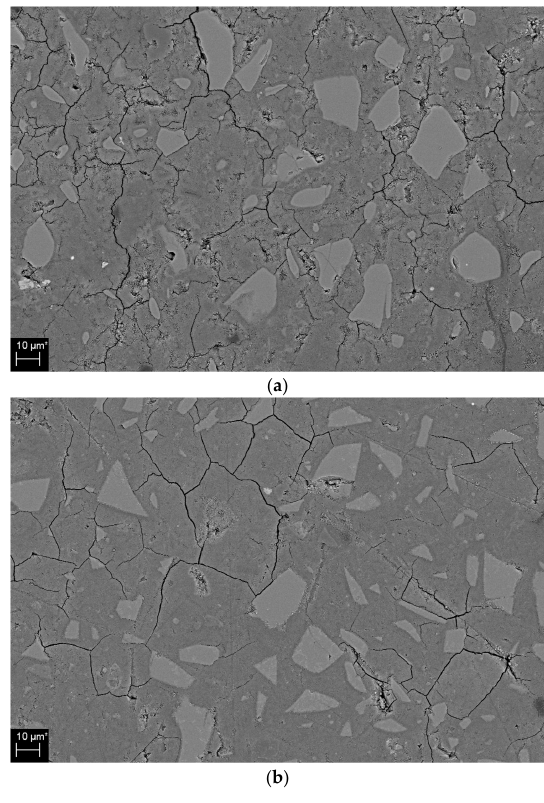
Figure 8. Thermal analysis (DTG): ( a ) 5% activator, ( b ) a magnification of less than 300 °C in ( a ), ( c ) 10% activator, ( d ) a magnification of less than 300 °C in ( c